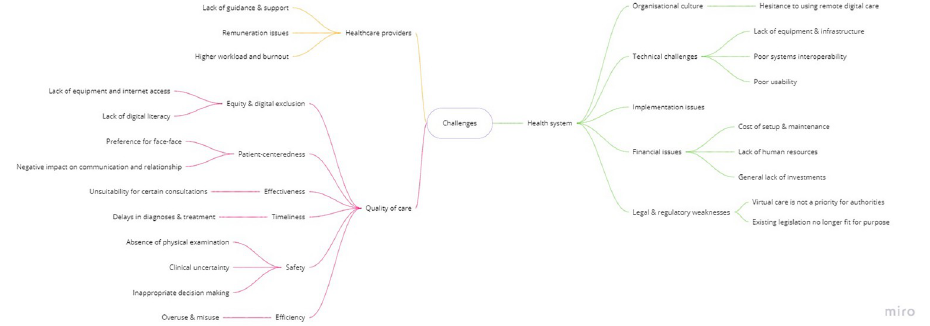
Fig 2. Conceptual map of main challenges